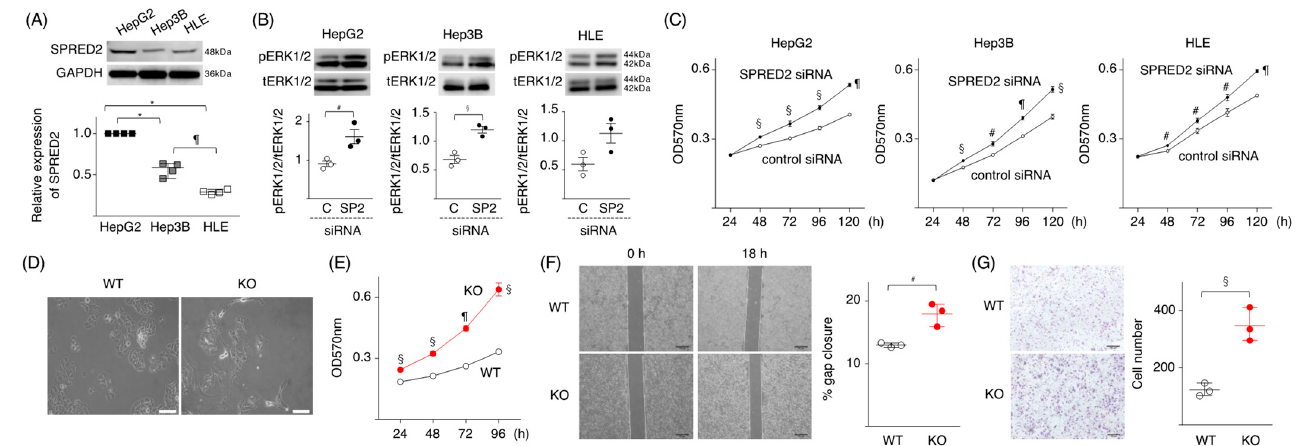
Figure 1. SPRED2 negatively regulates cancer cell proliferation, migration, and invasiveness. ( A ) The expression level of SPRED2 in HepG2, Hep3B and HLE cells was evaluated by western blotting. Band densities were digitized and semi-quantitated ( n = 4, each). The level in HepG2 was regarded as 1. ( B ) ERK1/2 phosphorylation in HepG2, Hep3B and HLE, transfected with SPRED 2-specific (SP2: ● ) or non-targeting control siRNA (C: ○ ) by western blotting ( n = 3, each). ( C ) The proliferation of each cell line was evaluated by MTT assay. ( D ) WT- and SPRED2-KO cells (2 × 10 5 /well) were incubated in 60 mm plastic dishes for 24 h and the cell morphology was examined under microscopy. Representative photos are shown. Scale bars: 50 µ m. ( E ) The proliferation of WT- and SPRED2-KO cells was evaluated by MTT assay. ( F ) Migration/proliferation of WT- and SPRED2-KO cells by a scratch assay. Left panel, the images were captured with an inverted microscope. Representative photos are shown. Scale bars: 200 μ m. Right panel, the gap distance at different time points was measured by Image J software ( n = 3, each). ( G ) Matrigel invasion assay. Left panel, representative photos. Scale bars: 100 μ m. Right panel, three low-power fields (magnification, 10×) were randomly selected from each chamber to count the migrated cells ( n = 3, each). # p < 0.05, § p < 0.01, ¶ p < 0.001, * p < 0.0001, two-tailed unpaired t test ( A – C , E – G ).